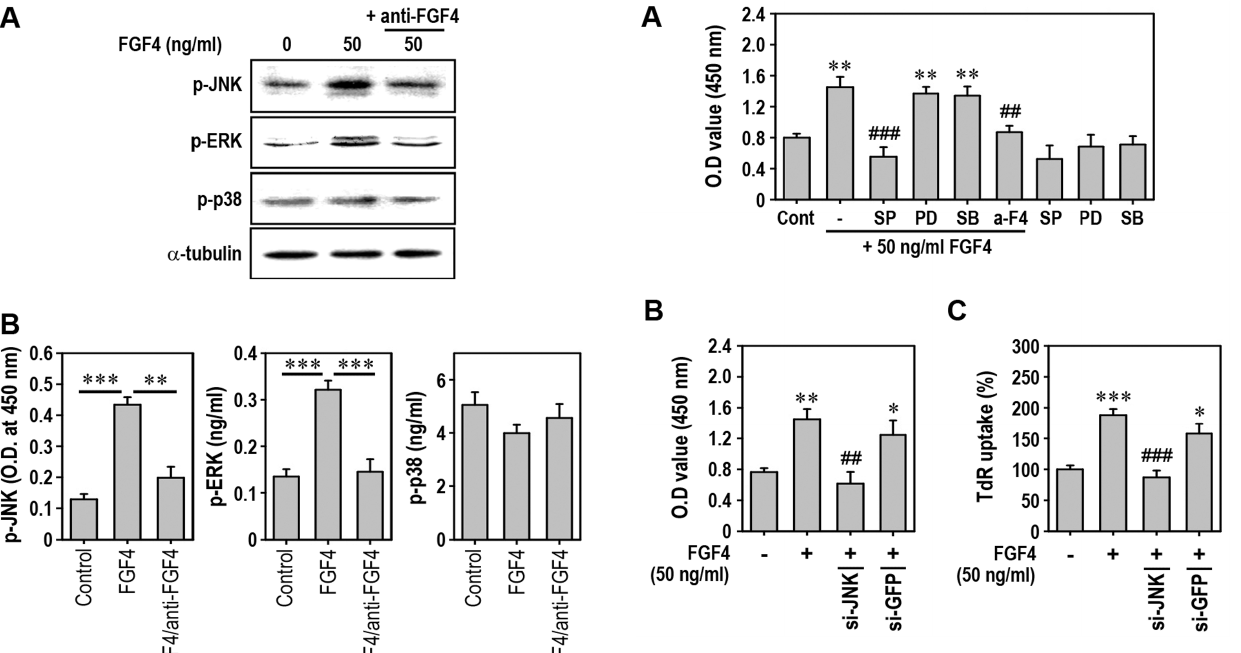
Figure 4. Inhibition of JNK suppresses FGF4-mediated prolif- eration of mESCs. (A) mESCs were pretreated with MAPK inhibitor or anti-FGF4 antibody 30 min before addition of 50 ng/ml recombinant FGF4, and cell proliferation rate was determined 48 h after treatment using a cell proliferation assay kit. In addition, siRNAs directed against JNK or GFP were transfected into mESCs. At 24 h post-transfection, cells were exposed to 50 ng/ml FGF4 and cell proliferation rate (B) and 3 H- TdR incorporation (C) were measured 48 h after treatment. *p , 0.05, **p , 0.01, and ***p , 0.001 vs. untreated cells. ## p , 0.01 and ### p , 0.001 vs. cells treated with FGF4